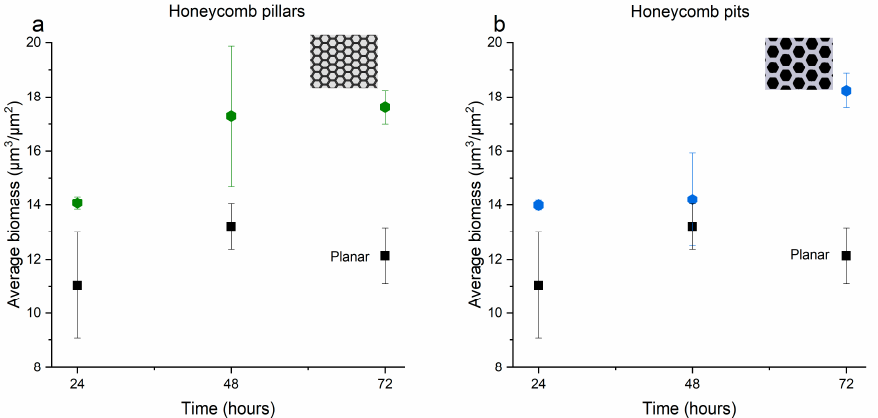
Figure 3. Composite graph illustrating the average bacterial biofilm biomass (µm 3 µm − 2 ) (bacterial volume/surface area) of Phaeobacter inhibens grown on the different surfaces, as a function of time: ( a ) Average biomass of bacterial biofilm grown on honeycomb pillars with a trench width of 5 µm, a side length of 10 µm, and a depth of 12 µm; ( b ) Average biomass of bacterial biofilm grown on honeycomb pits with a trench width of 5 µm, a side length of 10 µm, and a height of 13 µm. Data are depicted as mean + SD (n = 3).